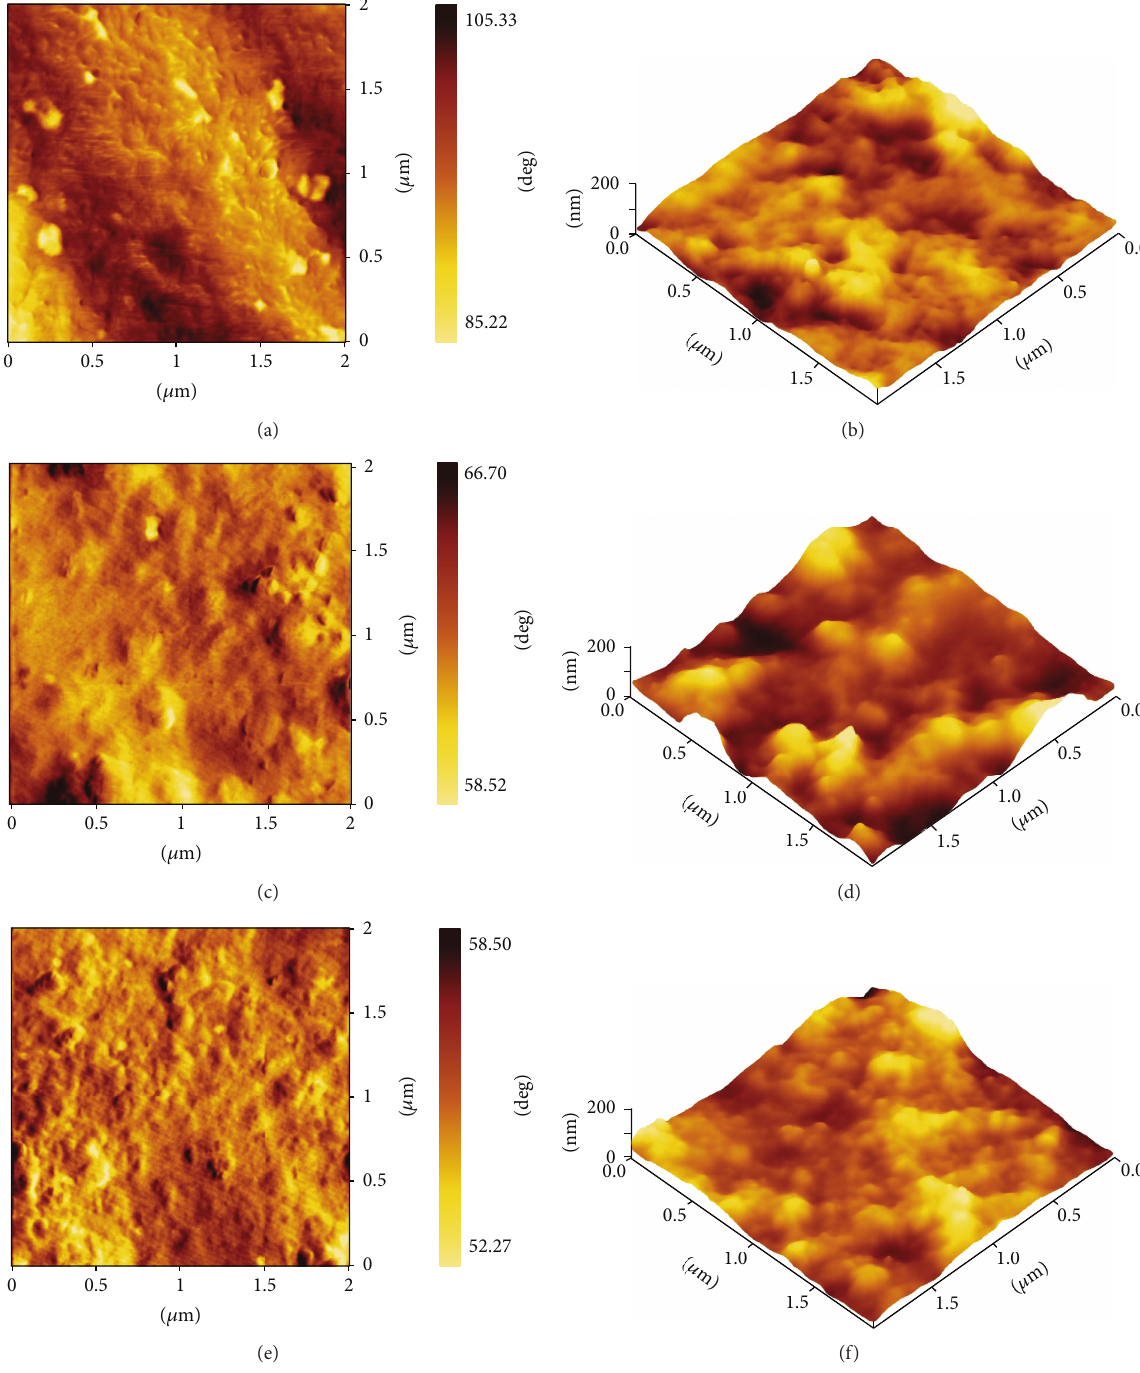
Figure 15: AFM micrographs of the donor-acceptor block copolymers (P3HT- b -PSFu) prepared by various ATRP systems; normal ATRP (top row), AGET-ATRP (middle row), and SR&NI ATRP (bottom row). The micrographs were recorded in a phase image tapping mode (left column) and a topographic mode (right